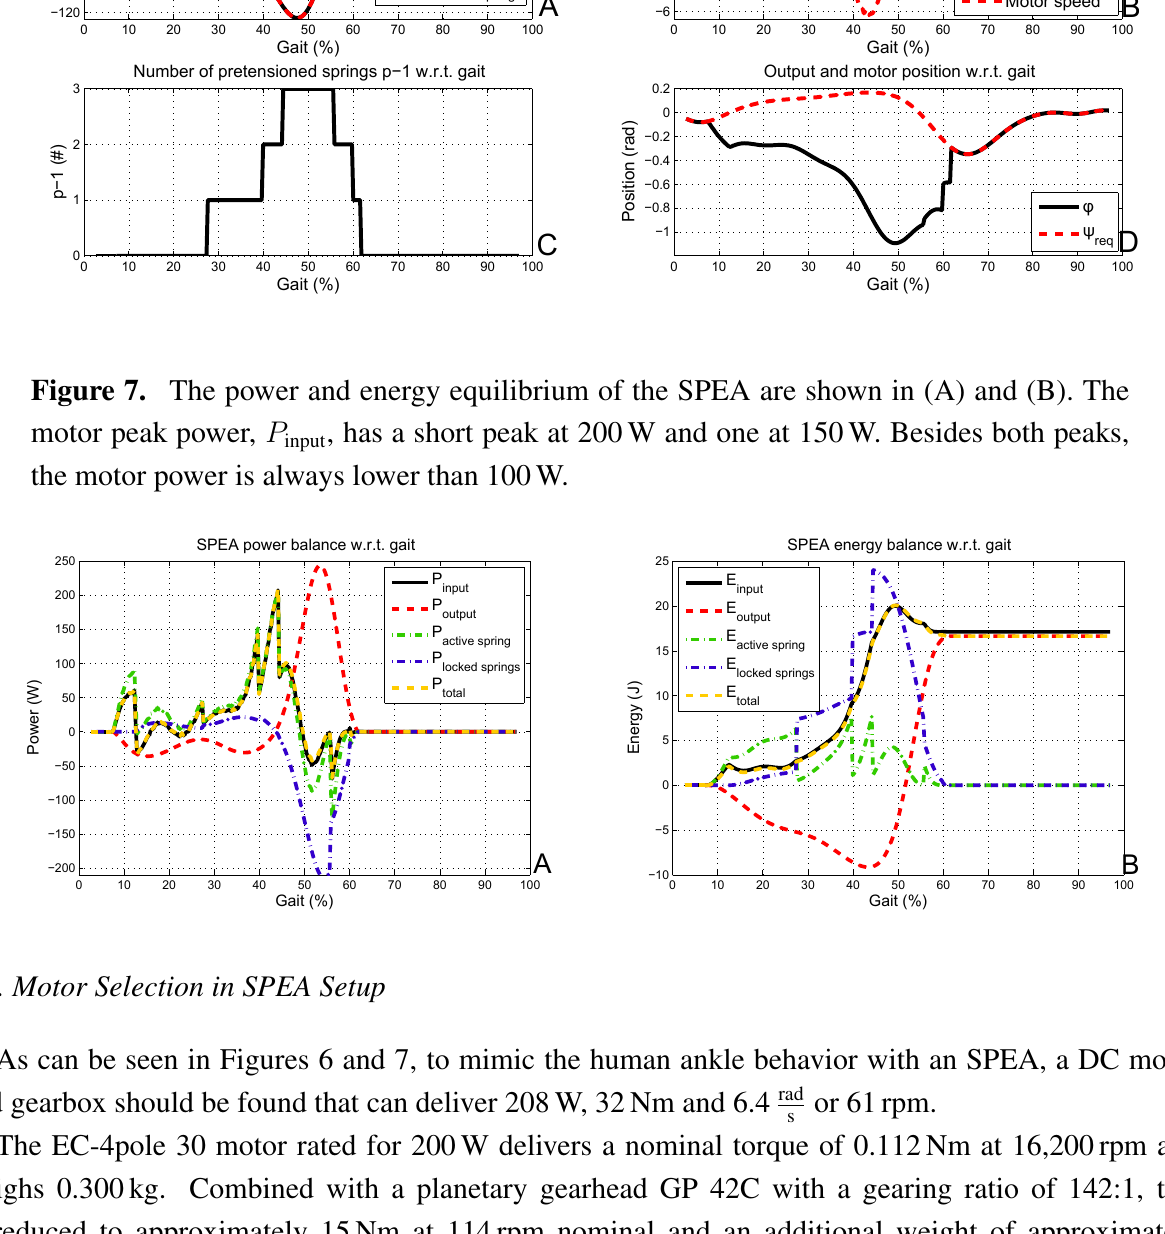
. The number req , and speed, req